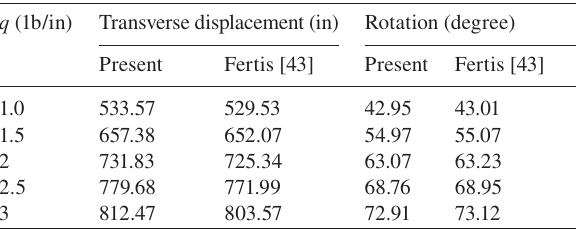
Table 3 Comparison of the present transverse displacements and rotations at the free end for an isotropic cantilever beam under uniformly distributed load.